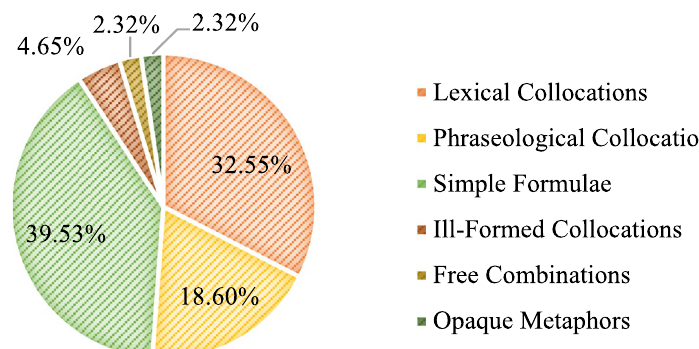
Fig. 4 Percentages of each phraseological unit type used in band scores